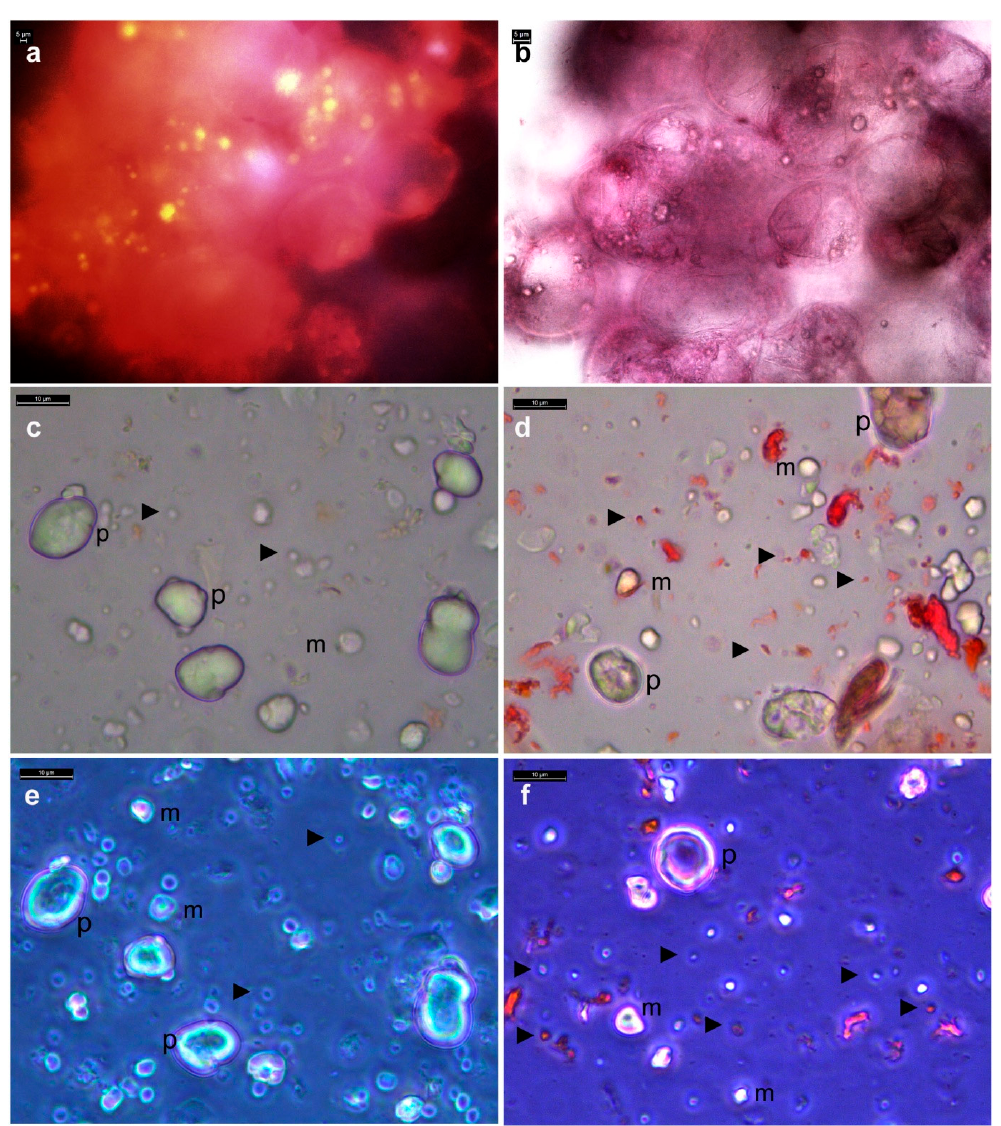
Figure 4. MitoTracker Orange (MTO) and DAPI staining of grape “FC01” callus cells. ( a ) Cells stained with 200 nM MTO displaying mitochondria in epi-fluorescence microscopy under N21 filter, ( b ) view of the same field under bright-field, ( c ) callus tissue homogenate at 100 mg mL − 1 in filter-sterilized water showing plastids (p) and mitochondria (m) under bright-field or ( d ) phase contrast with abundant Cytobacts in the background ( ► ); ( e ) tissue homogenate under bright- field or ( f ) phase contrast in the presence of 0.01% safranin showing plastids, mitochondria and Cytobacts (bar = 5 µm in ( a , b ) and 10 µm in ( c – f ) as marked).